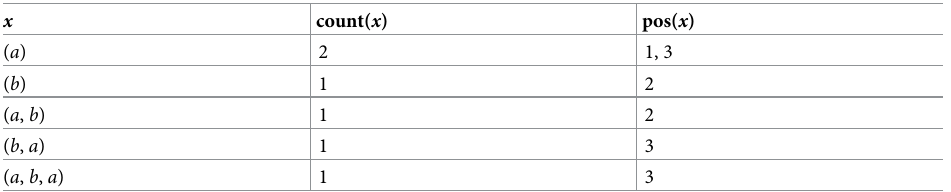
Table 2. n -grams learned from training on the sequence a, b,